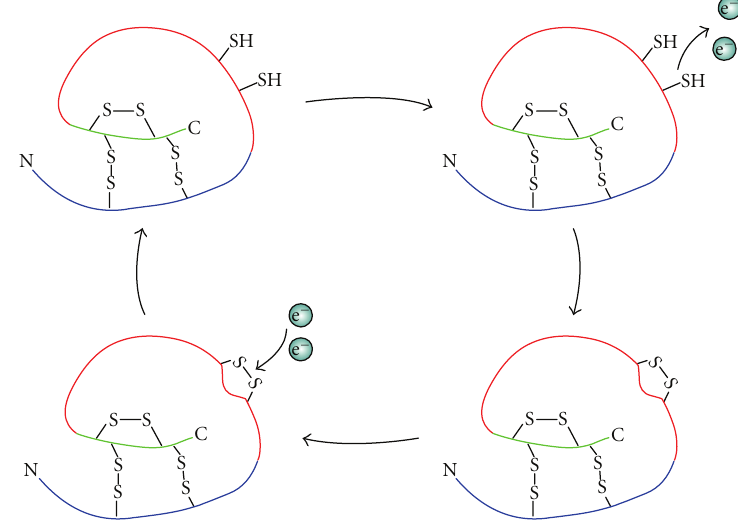
Figure 2: Cartoon of protein with redox-sensitive thiol switch. Structural disulfides can be seen on the inside of this protein, protected from redox reactions (those attached to the green and blue segments). A redox-sensitive thiol/disulfide switch is depicted on the protein surface (attached to the red segment). When reduced the redox-sensitive switch is in its dithiol state, however, when these thiols become oxidised (i.e., electrons are removed by an oxidant such as ROS) they bond to form a disulfide, altering the structure and/or function of the